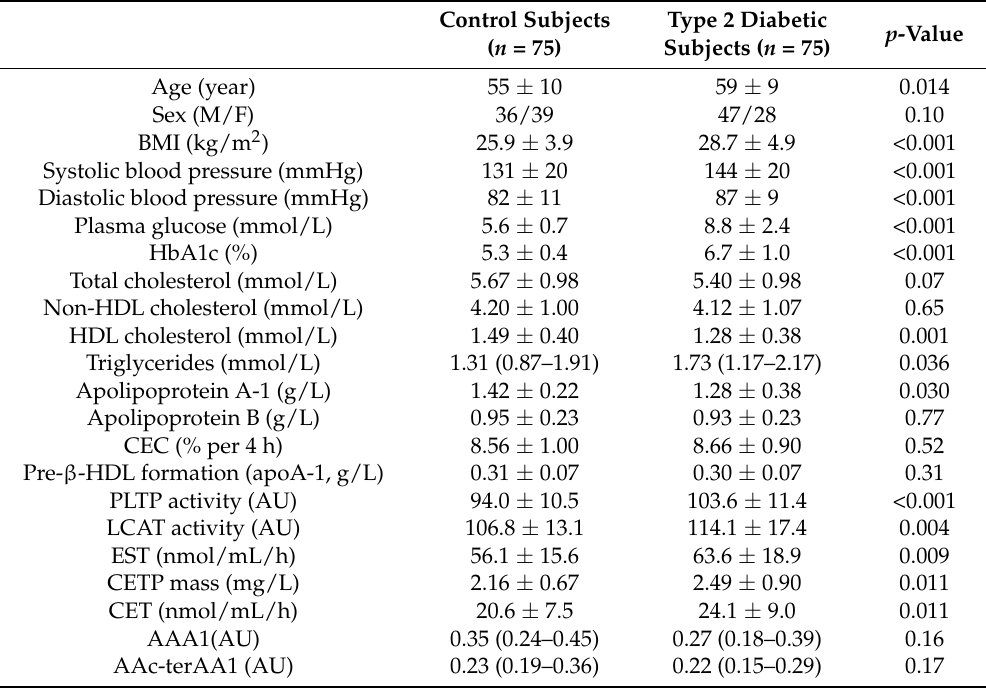
Table 1. Clinical and laboratory characteristics of 75 control subjects and 75 Type 2 diabetic patients.